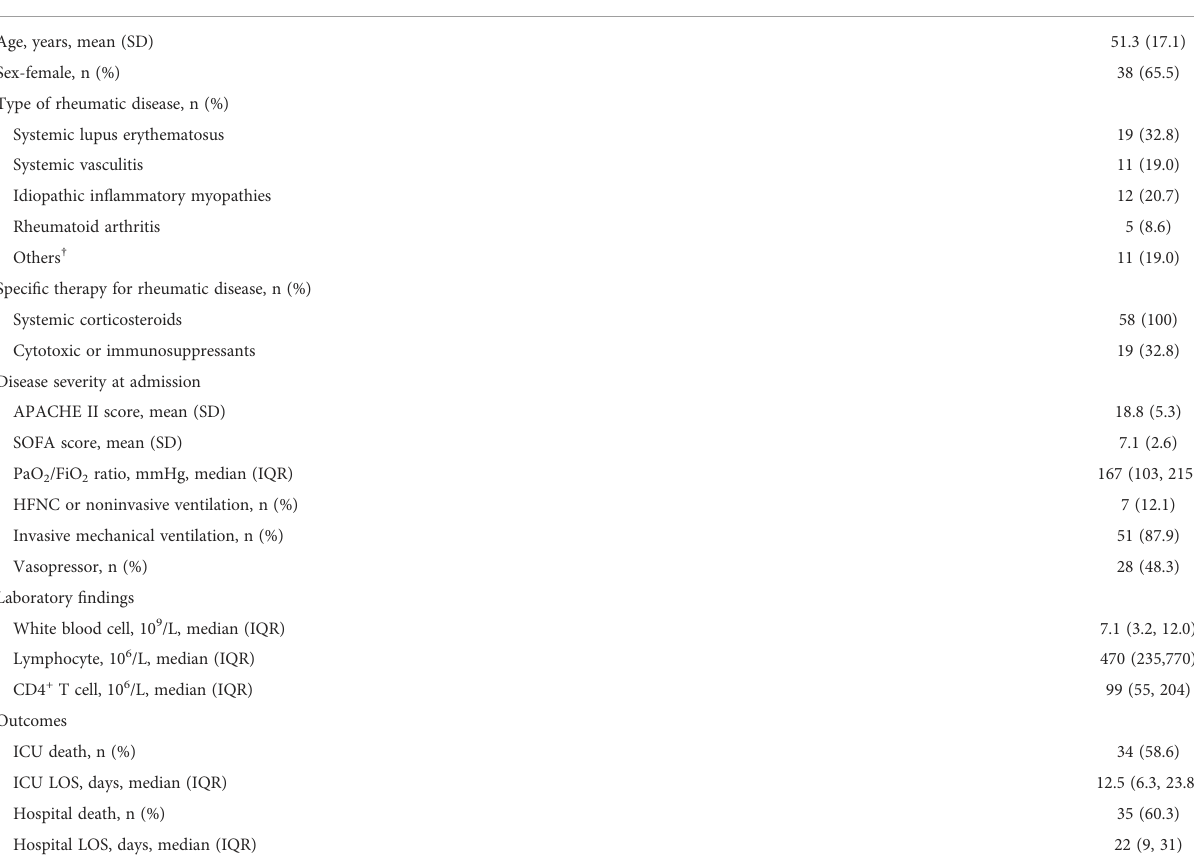
TABLE 1 Characteristics of 58 critically rheumatic patients with suspected